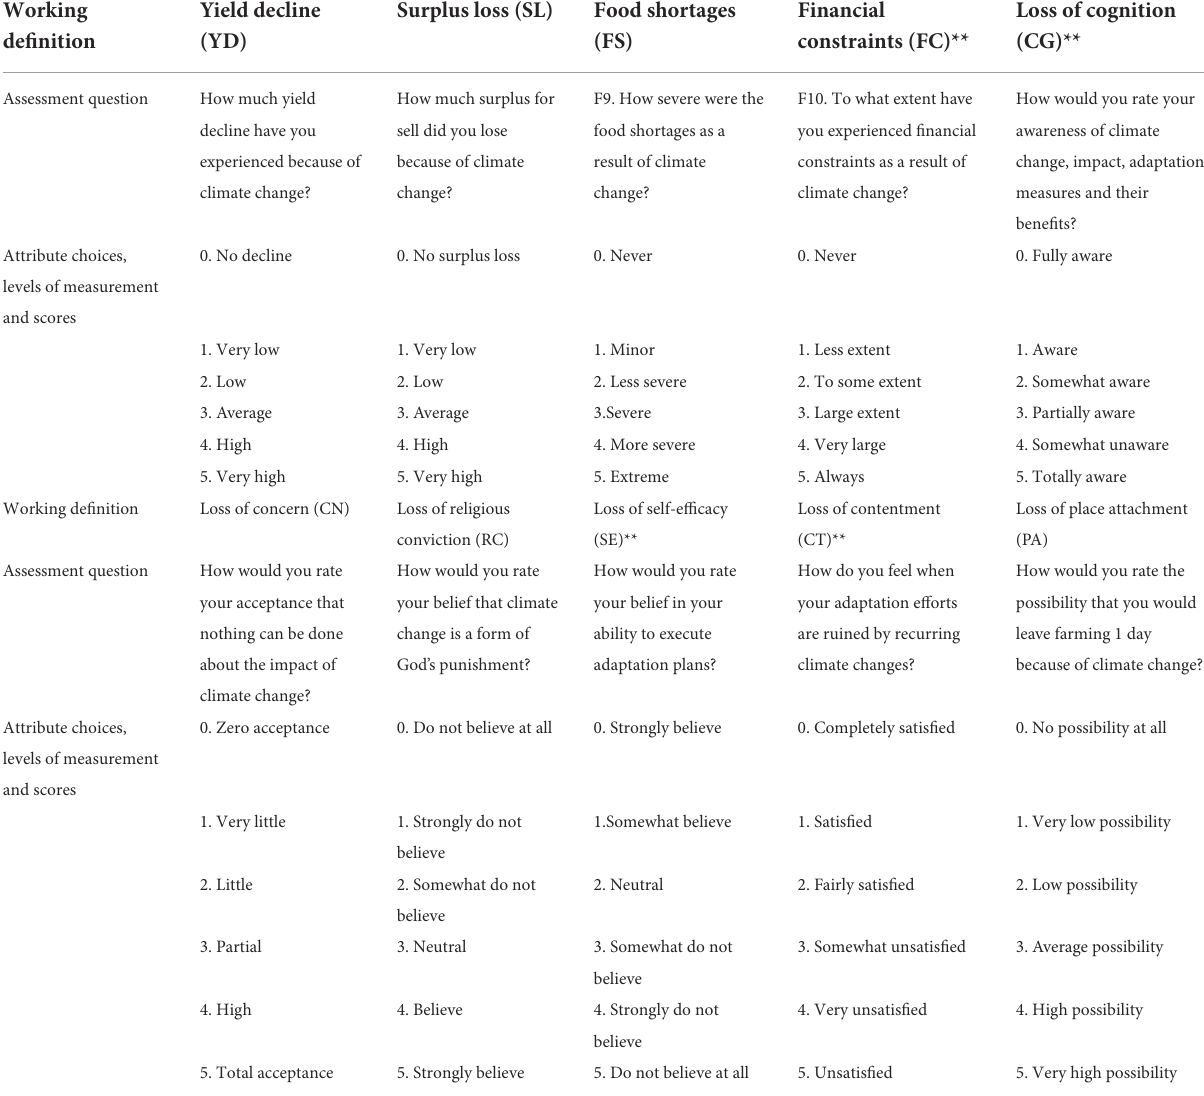
TABLE 5 Evaluation tool for estimating pre-adaptation